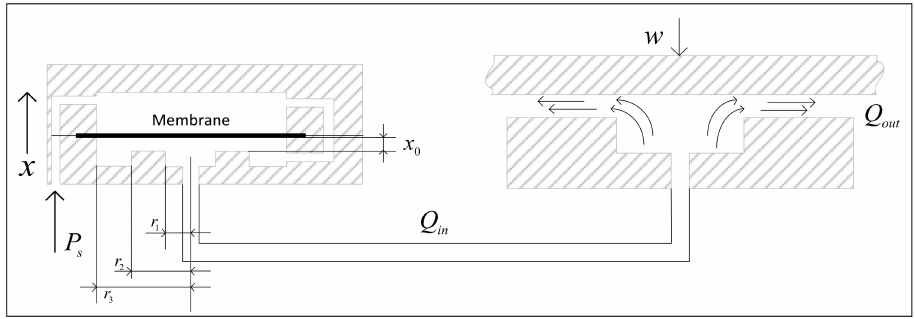
Figure 3. Schematic for membrane-compensated hydrostatic